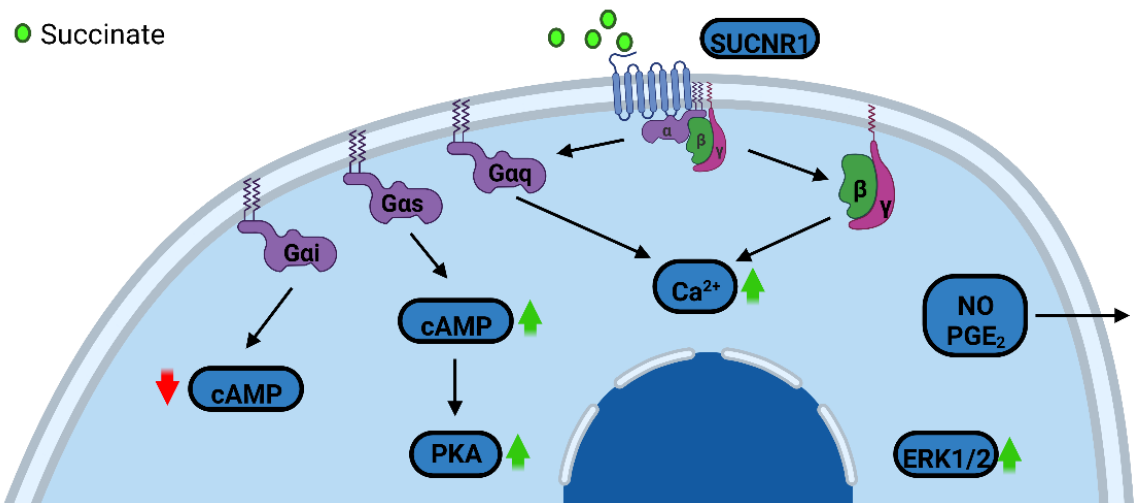
Figure 5. SUCNR1 downstream signaling machinery. Distinct G proteins pair with SUCNR1 medi- ating different cellular responses. cAMP: cyclic adenosine monophosphate, PKA: protein kinase A, ERK1/2: extracellular-signal-regulated kinases 1 and 2, NO: nitric oxide, PGE 2 : prostaglandin E 2 . Red arrow denotes reduced levels while green arrows denote increased levels or activity.